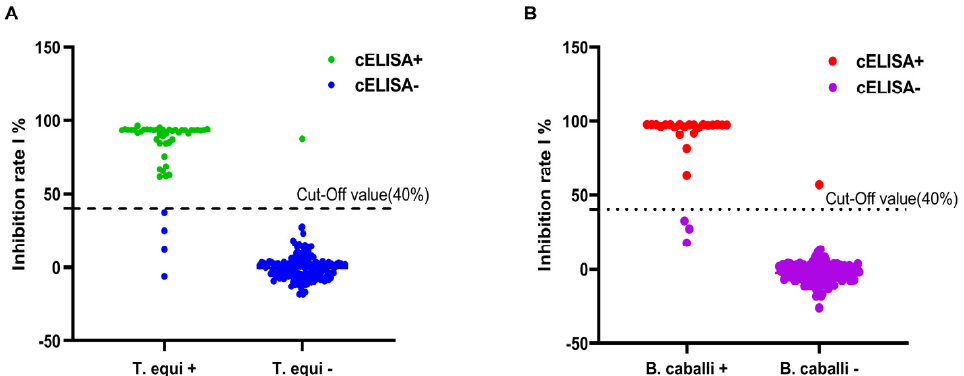
Figure 2. Determination of the cut-off value of the novel cELISA assays. Two hundred equine serum samples were assessed using the novel cELISA to determine the cut-off value. When the consistency and identification results of the serum samples by the novel cELISA methods were at their maximum, the cut-off values of both novel cELISA assays were found to be 40% ( A , B ).